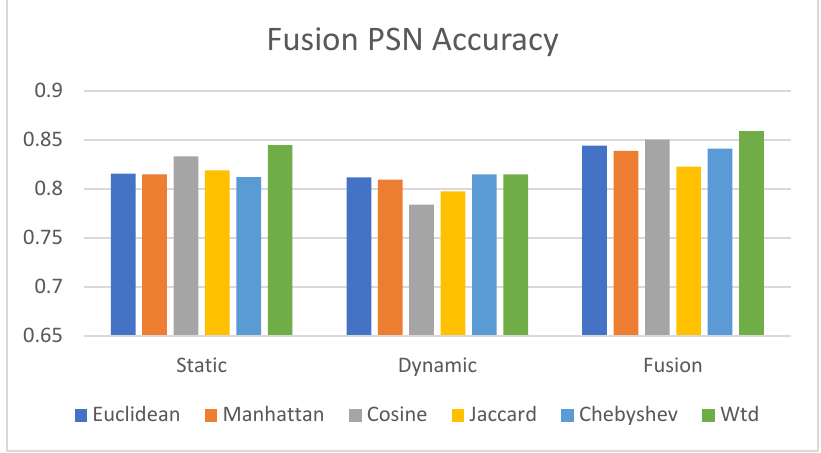
Figure 12. Accuracy of the fusion PSN.